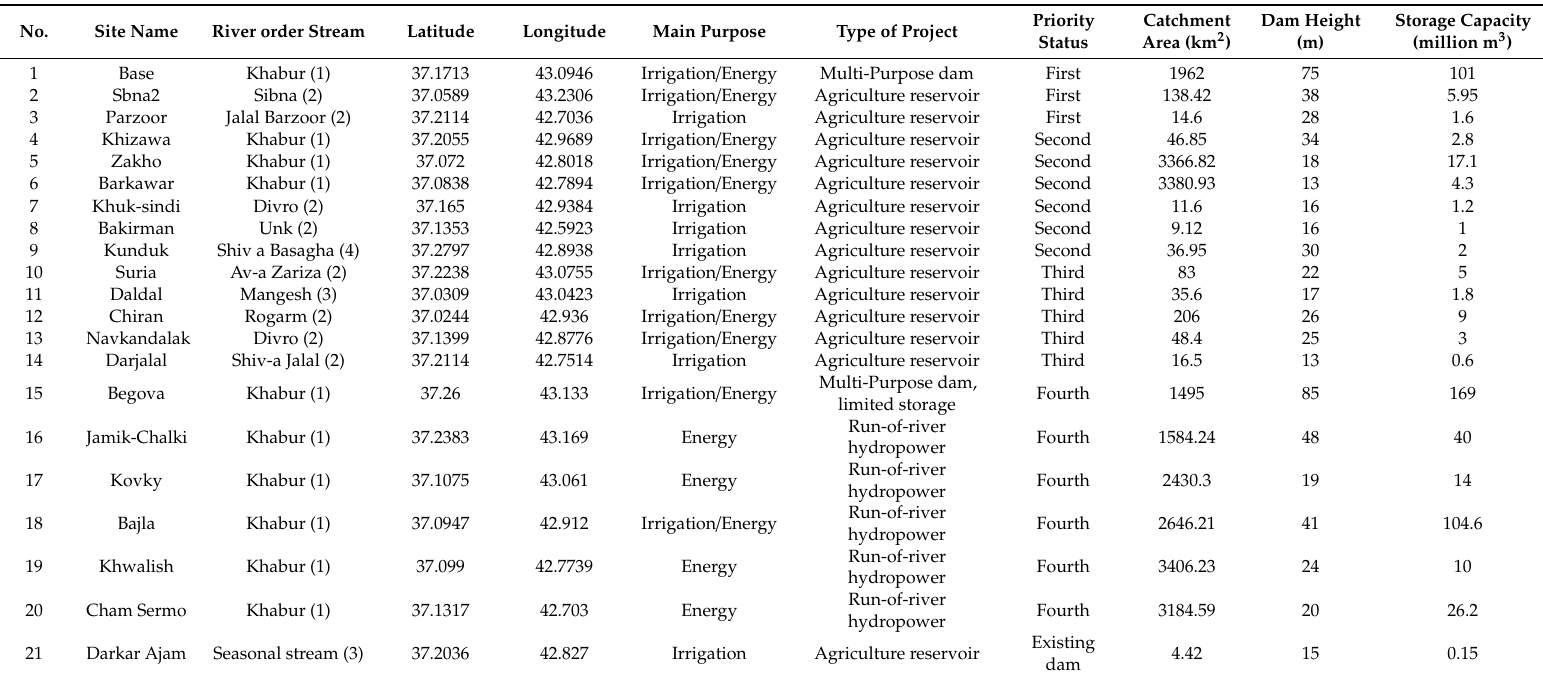
Table A1. Proposed sites of dams in the study area